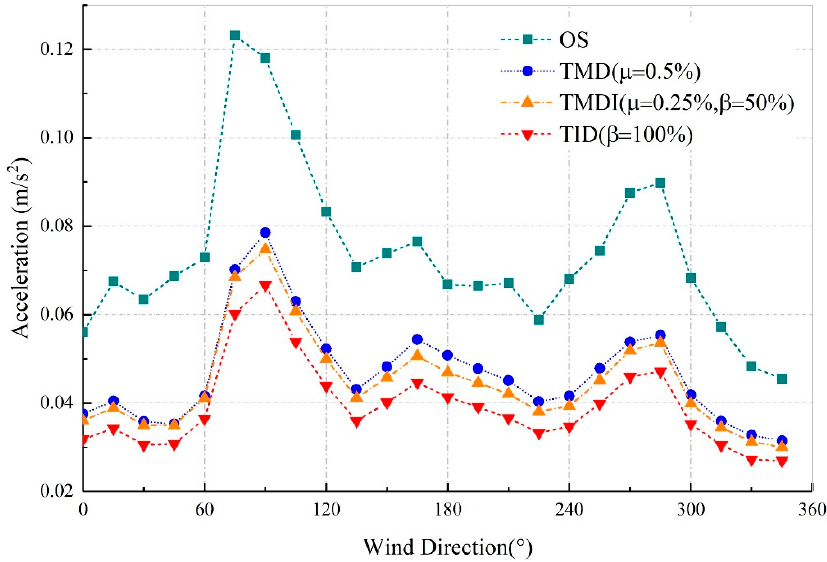
Figure 18. Extreme top-floor acceleration response at the x -axis corresponding to wind directions ranging from 0° to 345°.